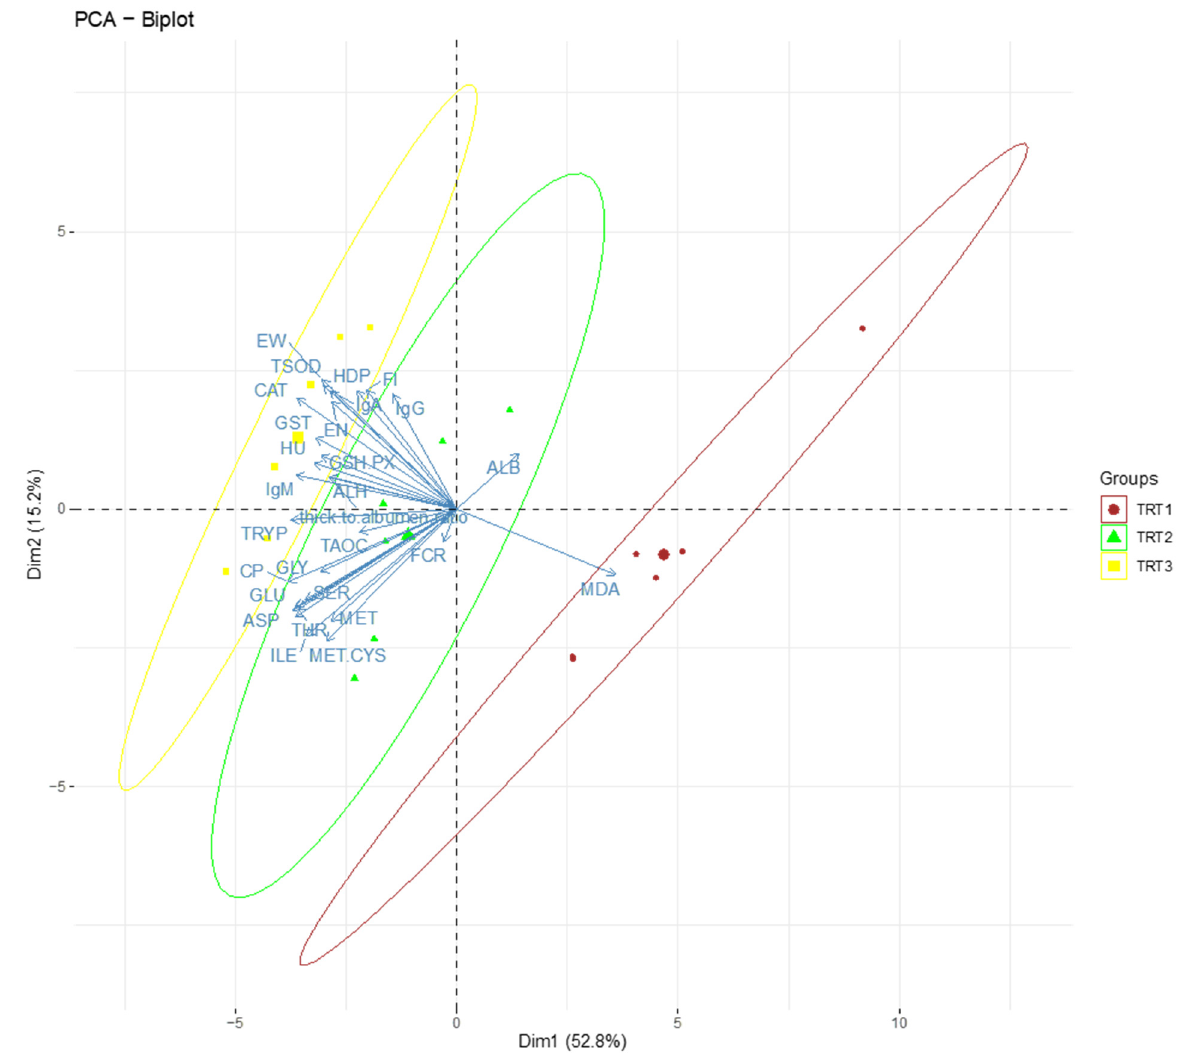
Figure 1. Biplot from the Principal Component Analysis of dietary treatments: Treatments 1, 2, and 3 correspond to red, green, and yellow.